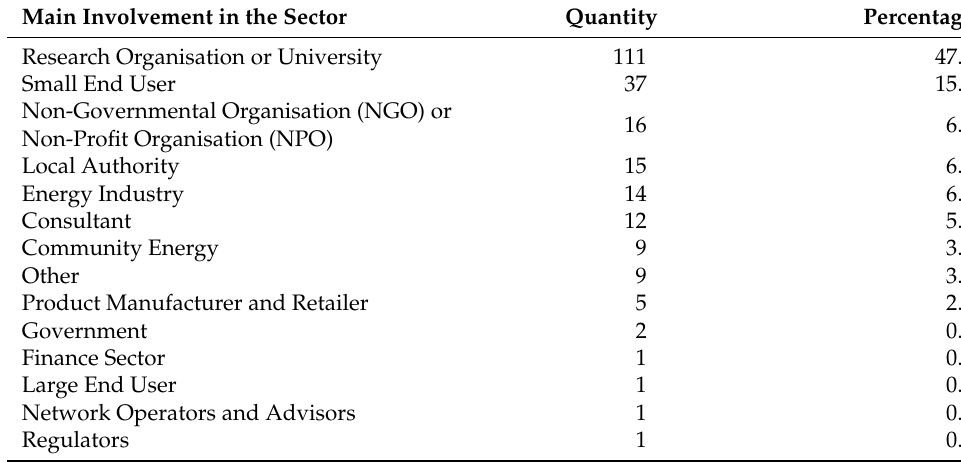
Table 2. Different types of stakeholders who completed the survey.